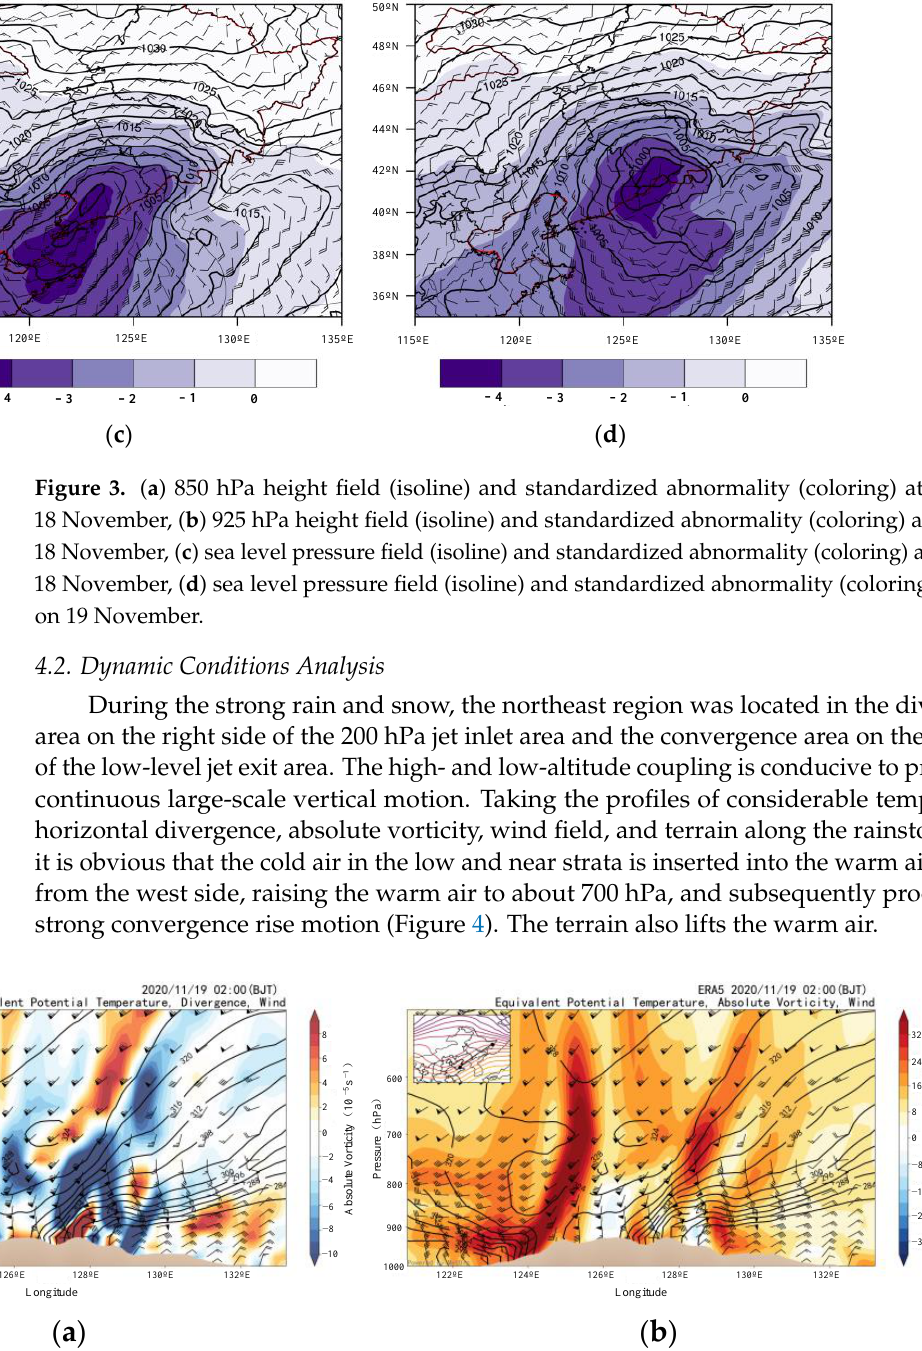
Figure 4. ( a ) equivalent temperature (contour), divergence (color) and profile wind at 02:00 on 19 November, ( b ) equivalent temperature (contour), absolute vorticity (color) and profile wind at 02:00 on 19 November.